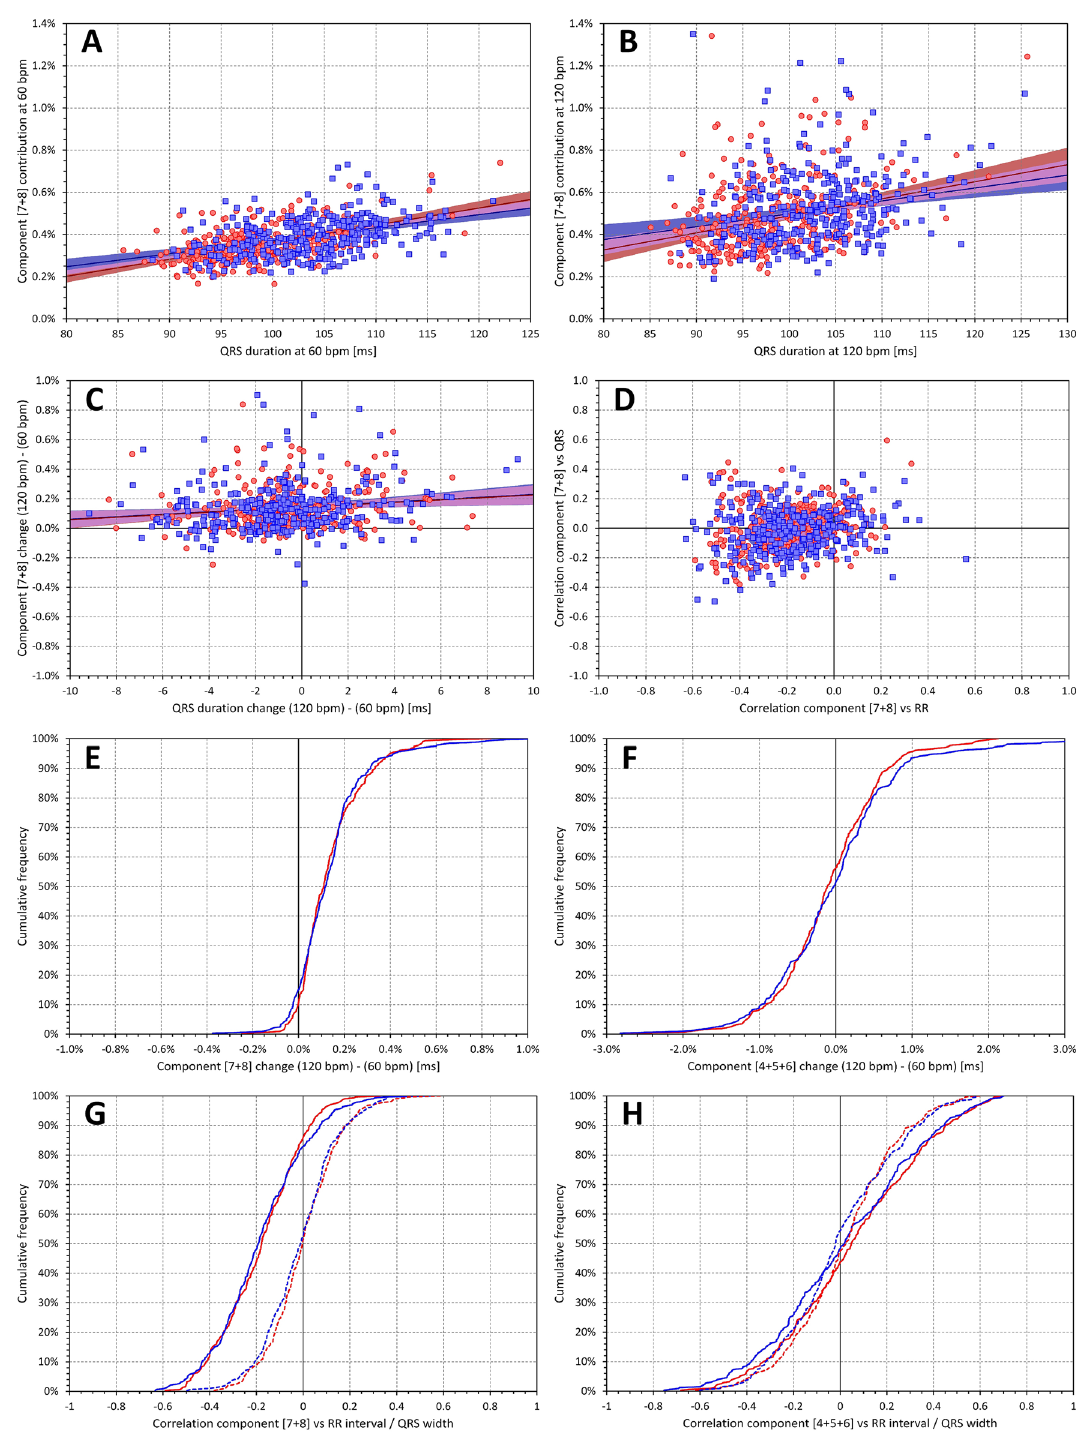
Figure 11. Panels ( A ) and ( B ) show scatter diagrams of the intra-subject relationship of component combination ∇ 7 + ∇ 8 to QRS duration at heart rate of 60 and 120 bpm, respectively. Panel ( C ) shows the scatter diagram of the ∇ 7 + ∇ 8 changes between 120 and 60 bpm to the corresponding changes of QRS duration. The meaning of the symbols in these scatter diagrams is the same as in the scatter diagrams of Fig. 6. Panel ( D ) shows the scatter diagram of the relationship between intra-subject correlation coefficients ∇ 7 + ∇ 8 versus RR interval and ∇ 7 + ∇ 8 versus QRS duration. The layout of this panel is the same as panels ( E ) and ( F ) in Fig. 7 (note that the data points are clustered so compactly that the underlying elliptical shapes are not easily visible). Panel ( E ) shows the cumulative distribution of intra-subject ∇ 7 + ∇ 8 changes between heart rates of 120 and 60 bpm; for comparison, panel ( F ) shows the same for ∇ 4 + ∇ 5 + ∇ 6 changes. Panel ( G ) shows the cumulative distribution of intra-subject correlations of ∇ 7 + ∇ 8 versus RR interval (full lines) and versus QRS duration (dashed lines). For comparison, panel ( H ) shows the same for intra- subject ∇ 4 + ∇ 5 + ∇ 6 correlations. In panels ( E ), ( F ), ( G ), and ( H ), the red and blue lines correspond to female and male subjects,